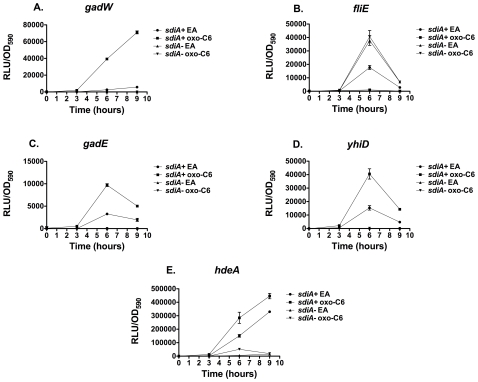
Regulation of AHL-regulated genes of E. coli K-12 and EHEC in liquid cultures at 30°C containing either 1 µM oxo-C6 or the solvent control, EA.Luminescence in relative light units (RLU) and OD590 were measured using a Wallac Victor2 1420 multimode plate reader at the time intervals noted. Each strain was assayed in triplicate and error bars represent standard deviation. A) AL4001/JLD800 (gadW), B) JLD604/JLD803 (fliE), C) JLD605/JLD804 (gadE), D) JLD607/JLD806 (yhiD), E) JLD610 /JLD809 (hdeA).